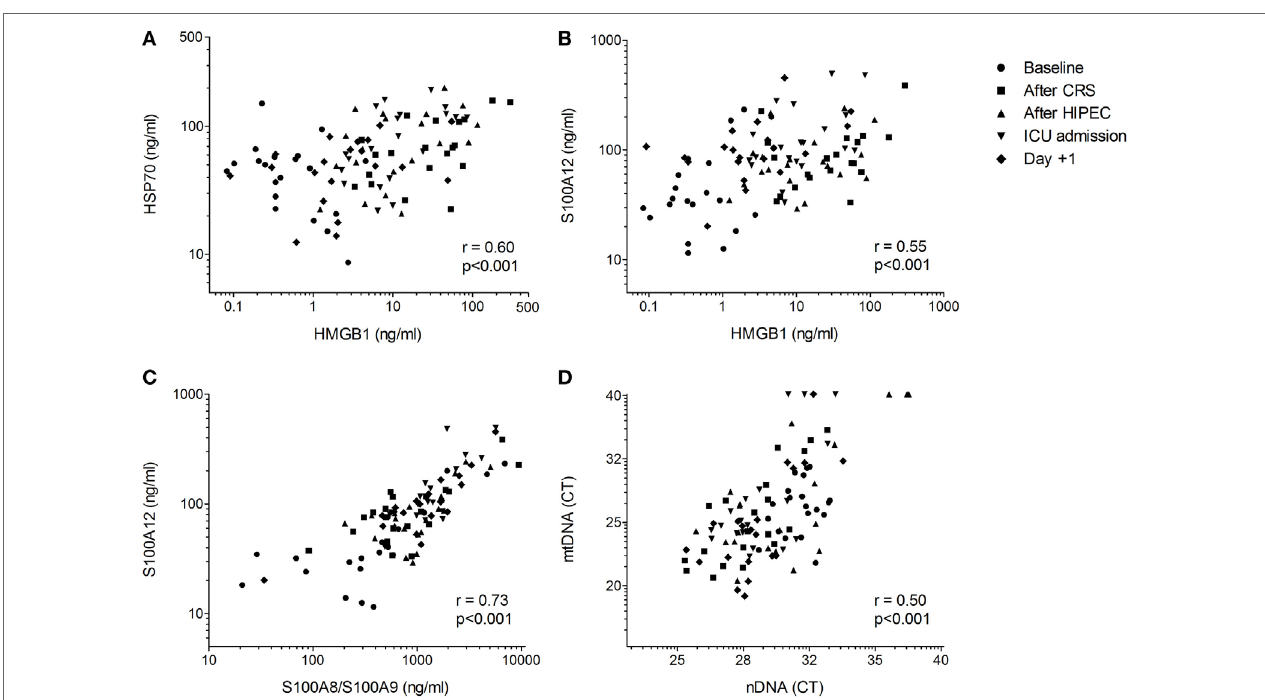
FigUre 2 | Correlations between danger-associated molecular patterns. Correlations between (a) high mobility group box (HMGB)1 and heat shock protein (HSP)70, (b) HMGB1 and S100A12, (c) S100A8/S100A9 and S100A12, and (D) nuclear (n)DNA and mitochondrial (mt)DNA in CRS-HIPEC patients ( n = 20, five time points per patient). Correlations were determined using the method for repeated measurements according to Bland and Altman